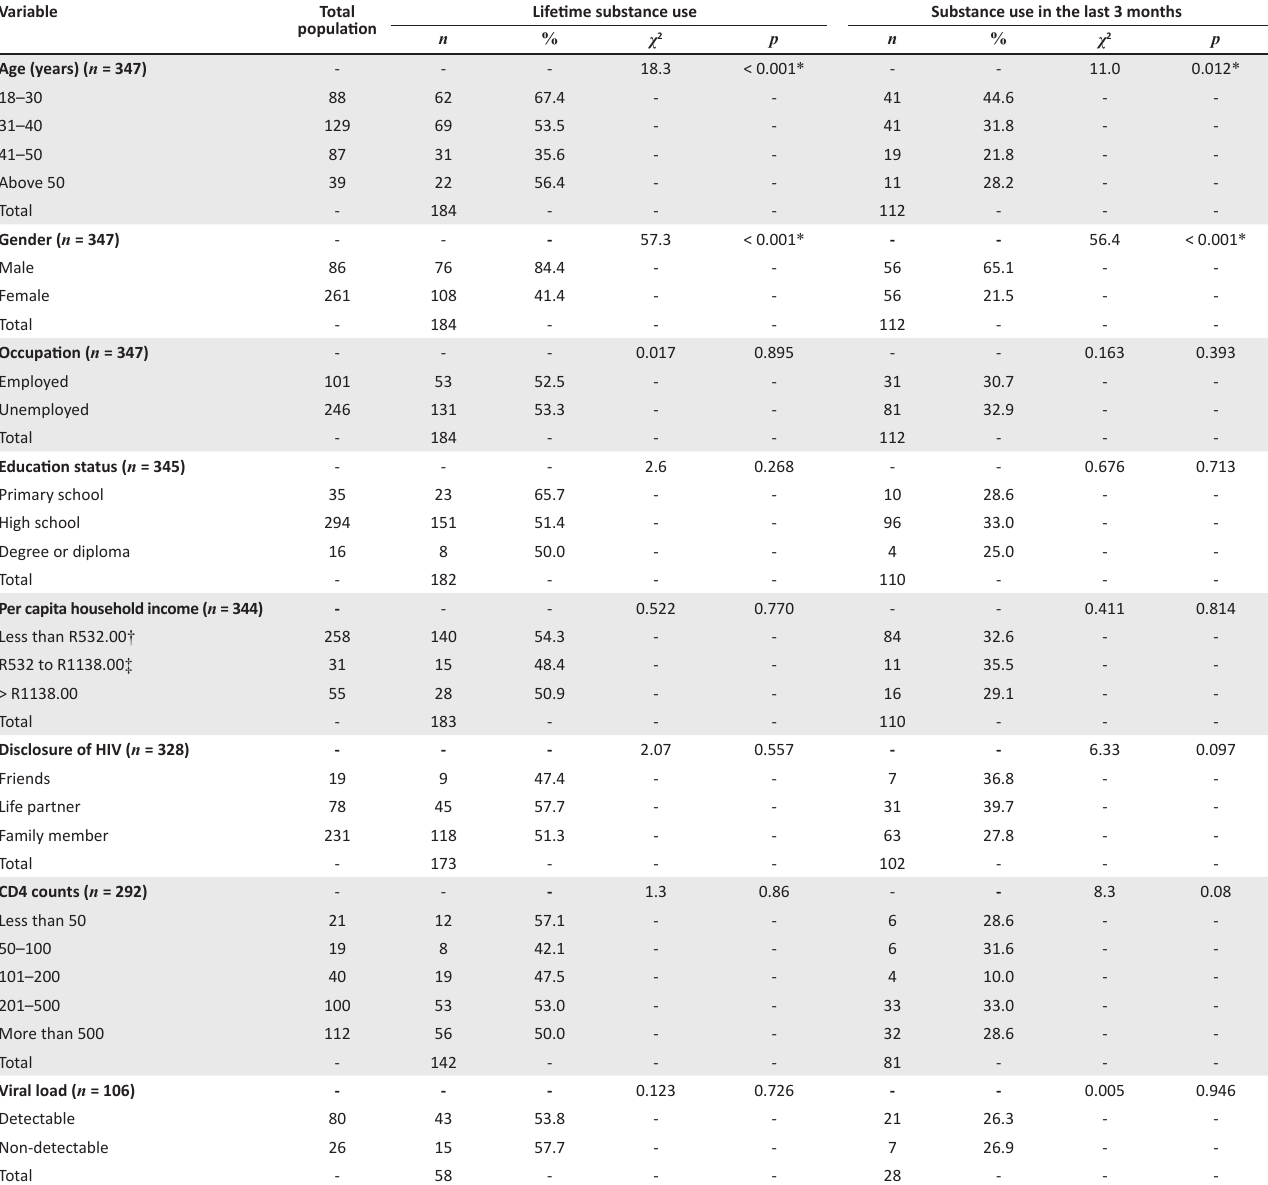
TABLE 1: Demographic and clinical characteristics of lifetime and current substance use amongst people living with HIV in Mthatha, South Africa ( n = 347).